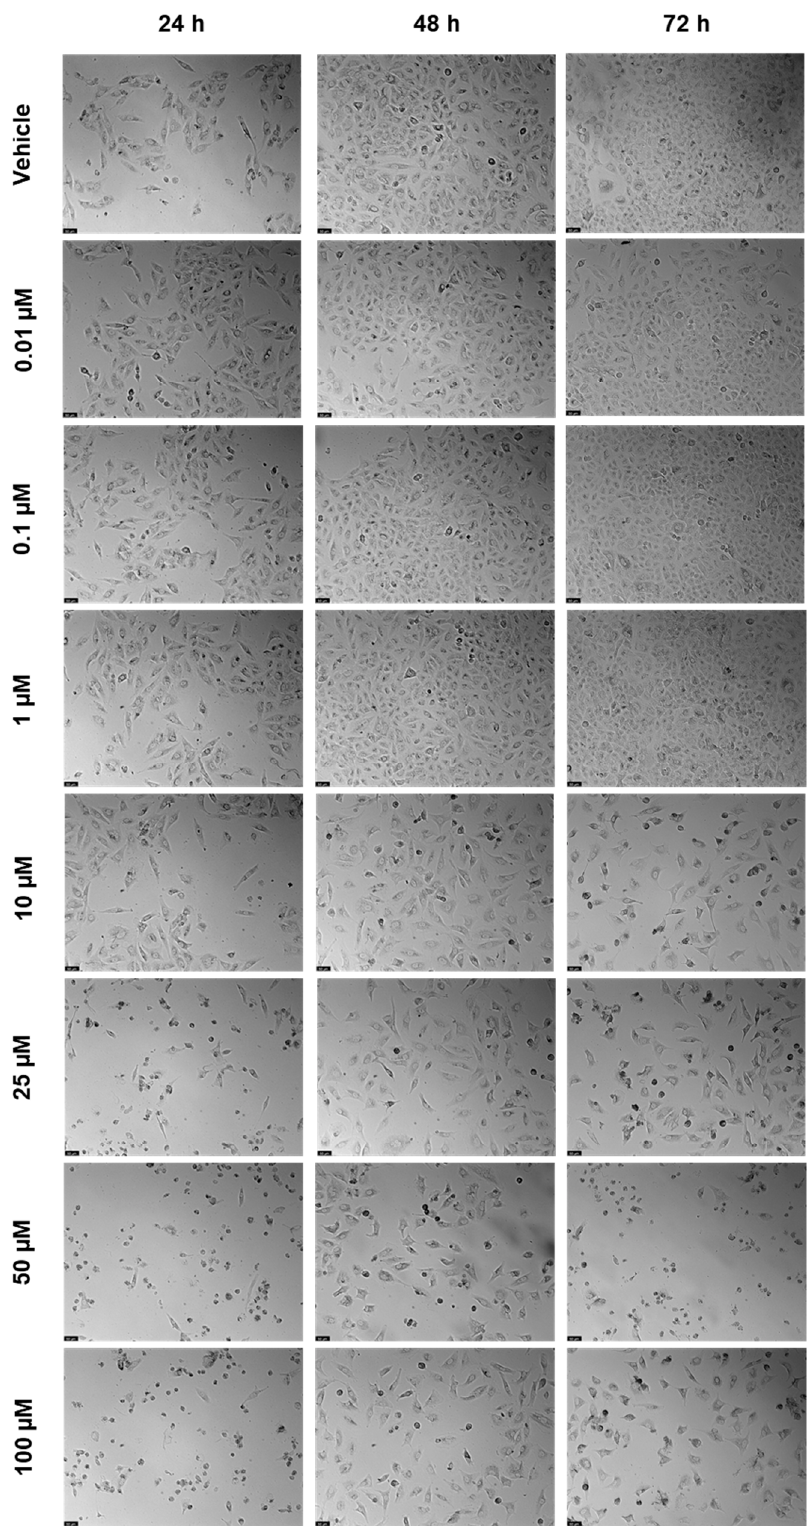
Figure 12. Morphological evaluation of A549 after exposure to increasing concentrations of 5-FU (0.01–100 μ M) for 24, 48, and 72 h. Control cells were treated with the vehicle (0.01% DMSO). These images are representative of three independent experiments. The scale bar is 200 μ M.